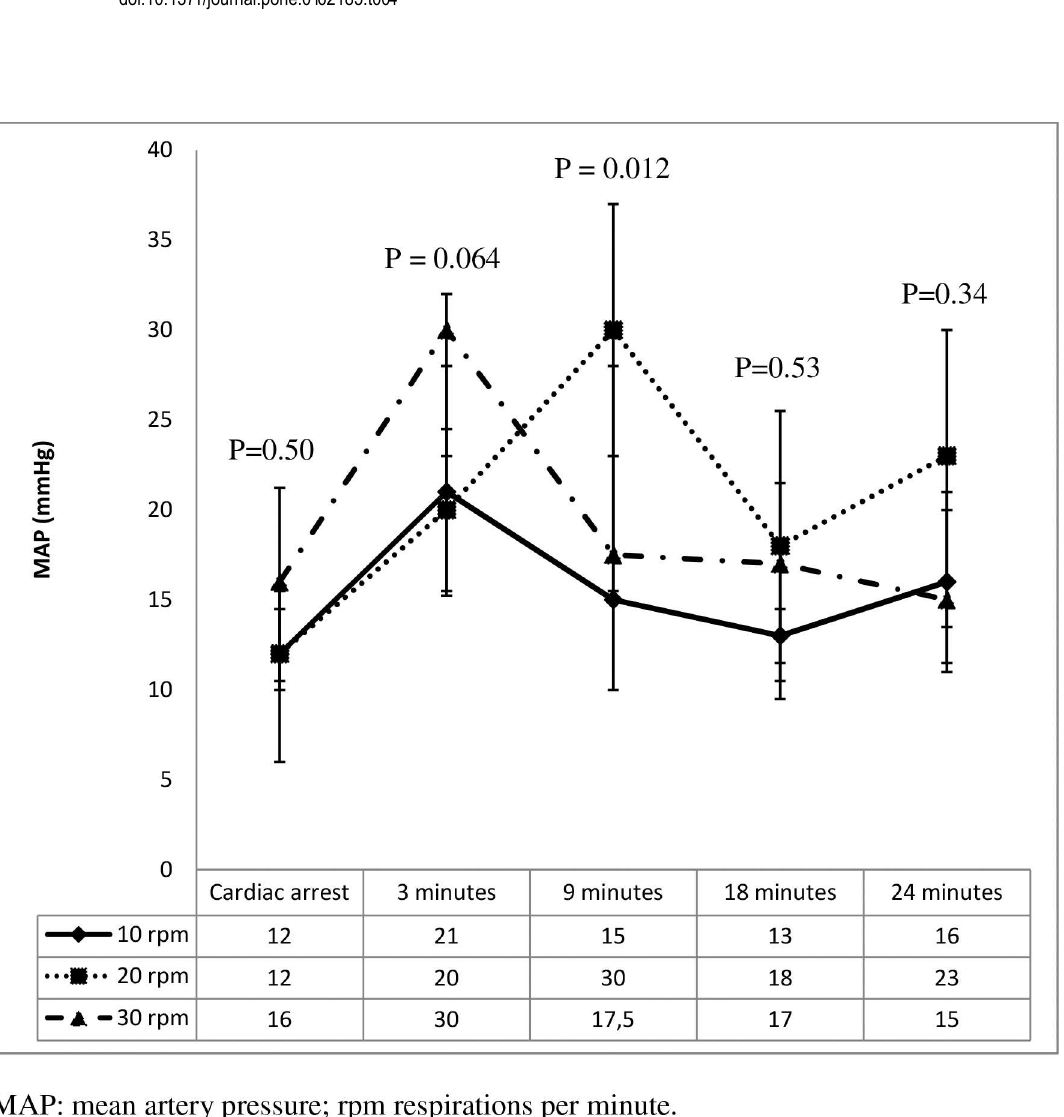
Fig 5. Meanarterypressurevalues